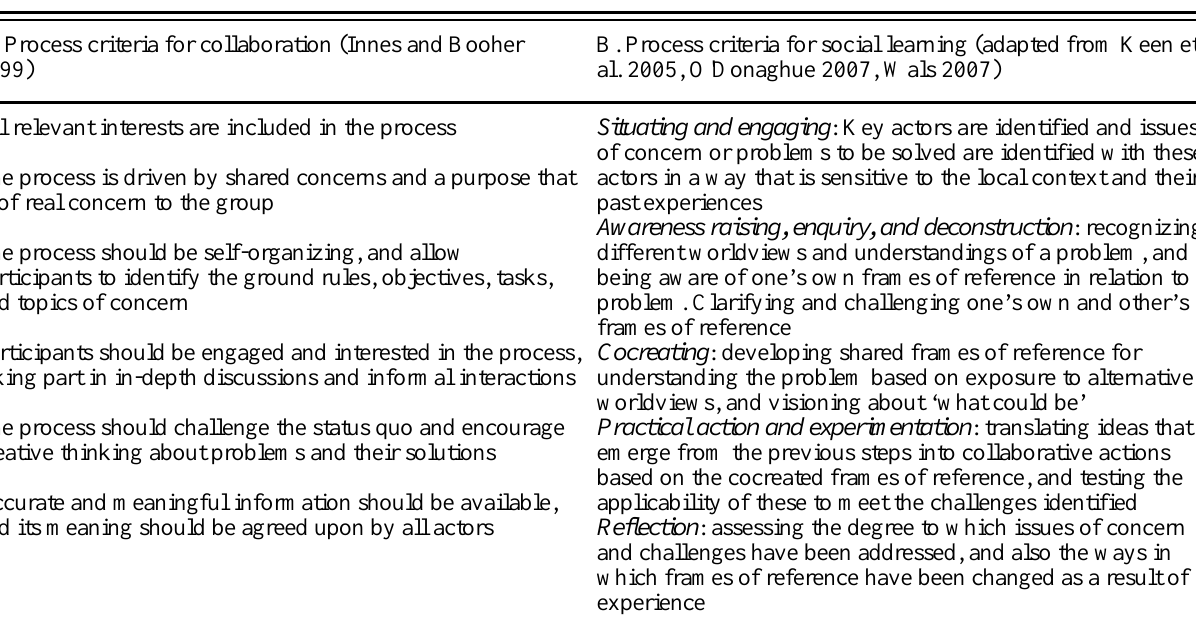
Table 1. Process criteria for evaluating collaboration and social learning. A. Process criteria for collaboration (Innes and Booher